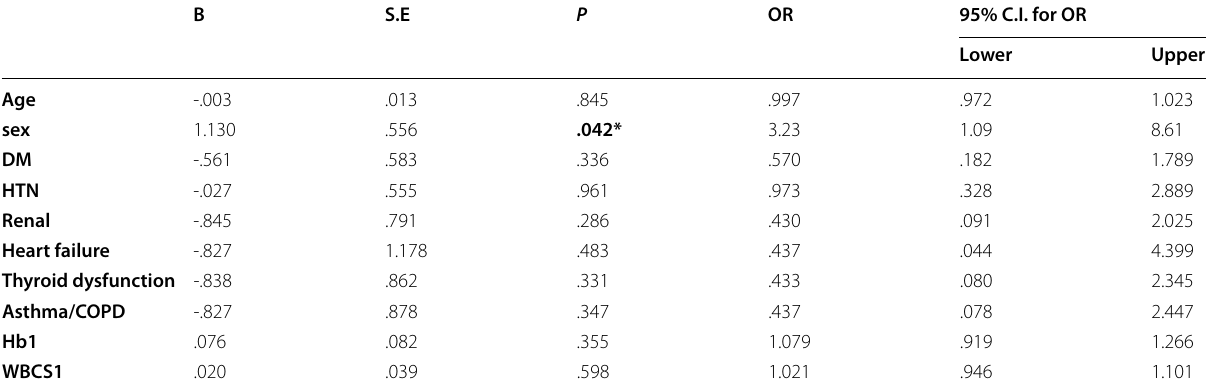
Table 3 The regression model predicting infection